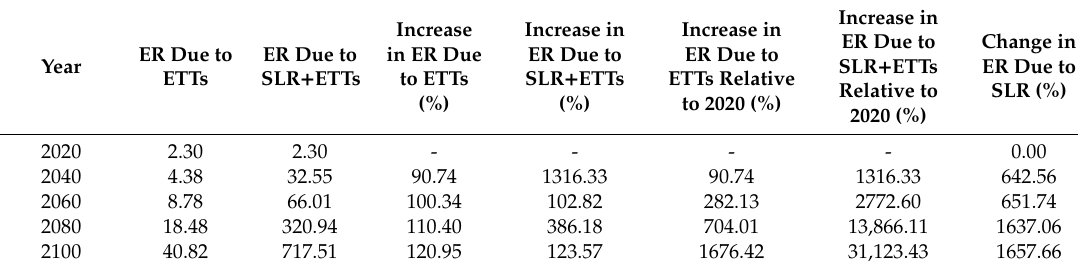
Table 4. Comparison of Economic Risks (ER) at Fethiye due to Earthquake Triggered Tsunami (ETTs) and Sea Level Rise (SLR).